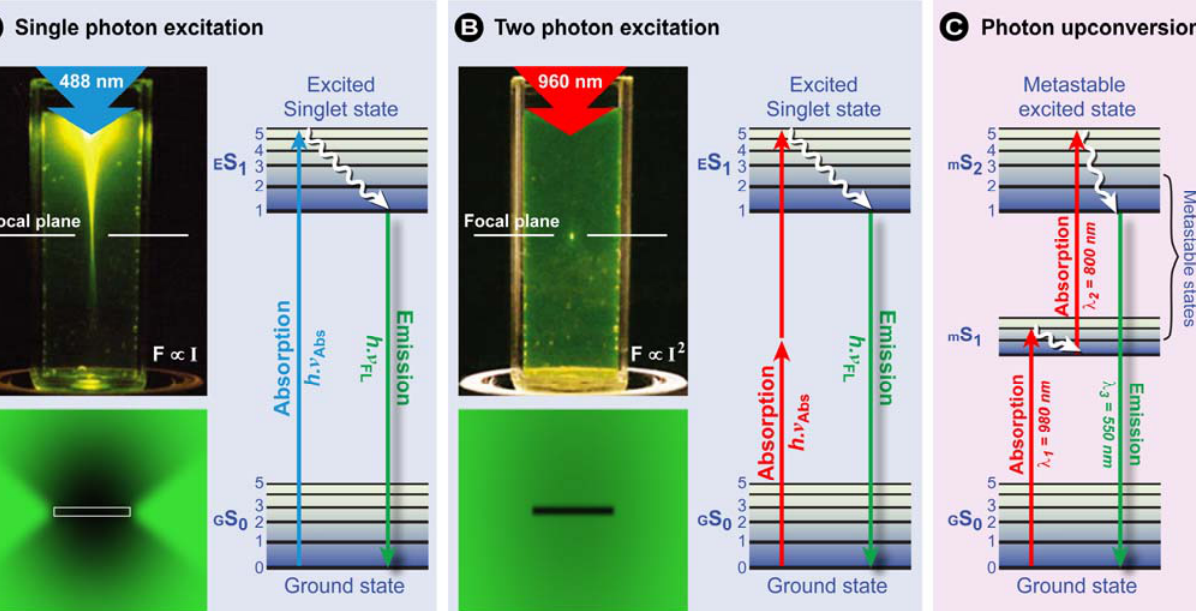
Figure 10. Comparison of the excitation profiles of ( A ) single photon, ( B ) two photon, and ( C ) upconverting excitation . From the light excitation pattern with 488 and 960 nm (0.16 NA) lasers in the cuvettes, it can clearly be seen that only in two photon excitation ( B ), the excitory beam is focused in a spot in the focal plane. Conversely, in single photon excitation ( A ), additional light emanates from above and below the focal plane. Bottom figures: repetitive scanning in the focal plane (x-y plane) in a fluorescein-stained formvar film shows that in two photon excitation only the focal plane photobleaches. The Jab ł o ń ski diagrams illustrate the differences in photon absorption between the various systems. In TPE, two photons of the same wavelength must arrive simultaneously in time and space to excite the electron. Conversely, upconverting fluorochromes (C) contain metastable states, as in this example for Europium (III) ions, which are sufficiently stable to allow sequential absorption of long wavelength photons. As a result, both TPE and photon upconversion show anti-Stokes shifts. Partially reproduced from [59] with permission from Macmillan Publishers Ltd: Nature Biotechnology ©